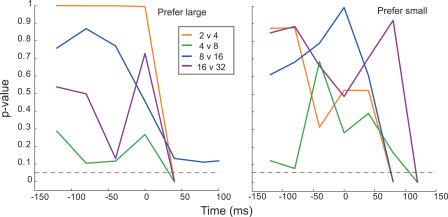
LIP Neurons Differentiate Numerosities SimultaneouslyFor the two groups of neurons, “prefer large” and “prefer small,” trials were sorted by number, and the average response was calculated in 40-ms bins. At each time point, responses were compared for pairs of numerosities closest to each other using a one-tailed, two-sample t-test to determine the time at which the responses began to differ. The resulting p-value is plotted as a function of time. The time to first discrimination did not occur later for larger numerosities, suggesting that numerosity is encoded via a parallel rather than serial process.